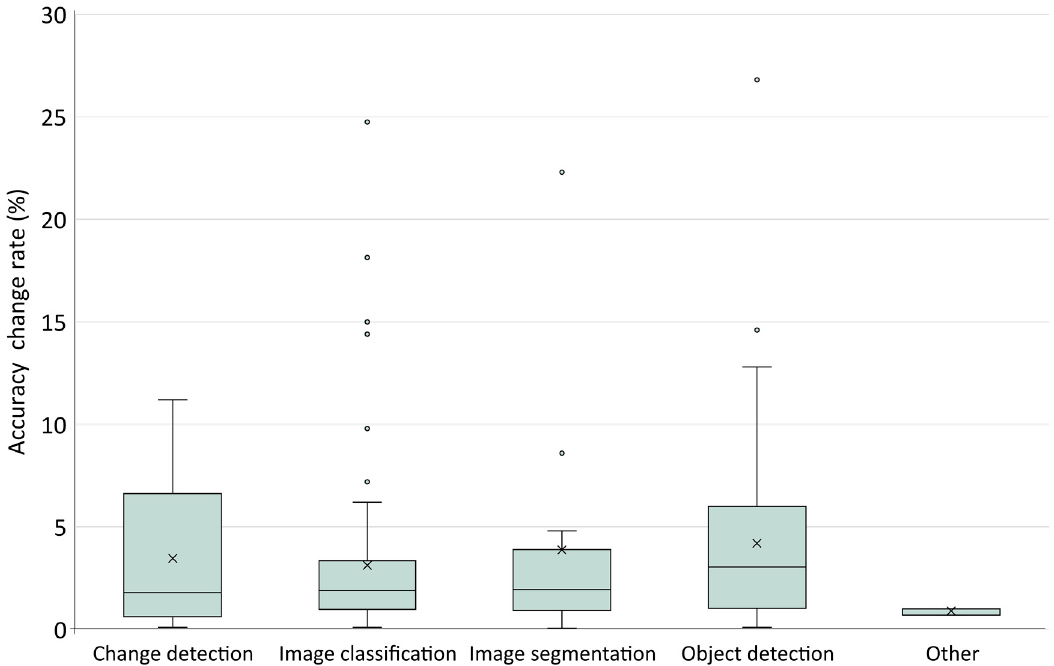
Figure 14. The effect of the use of the attention mechanism within the DL algorithms in terms of accuracy rate for different tasks in the papers.